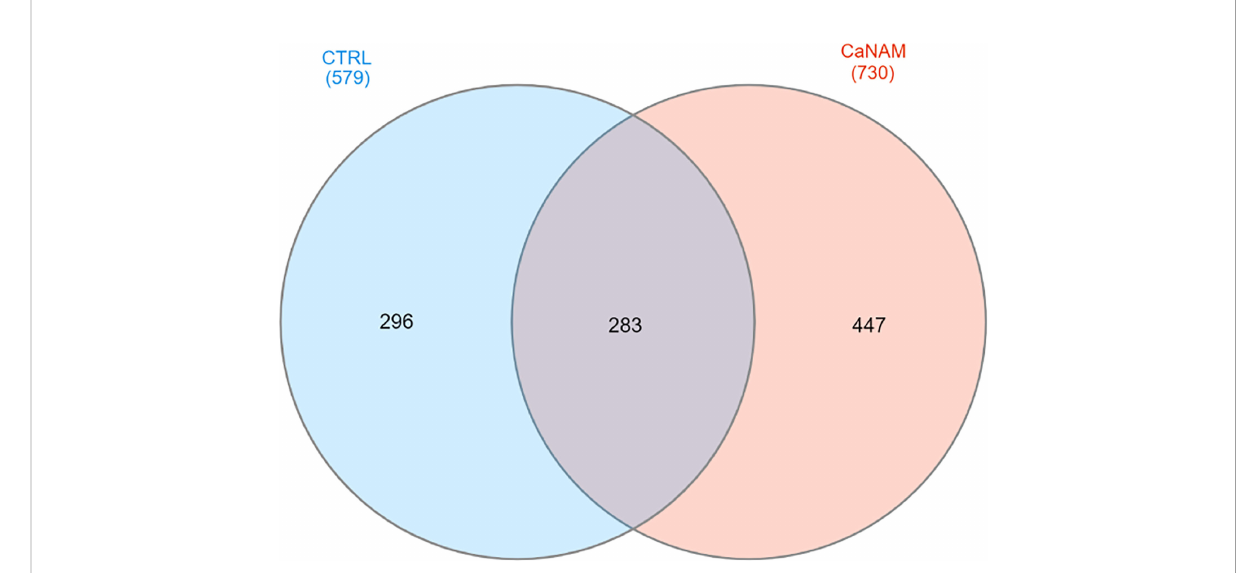
FIGURE 6 Venn diagram summarizing the number of ChIP enriched regions in CTRL and CaNAM. ChIP peaks annotations were plotted by InteractiVenn.